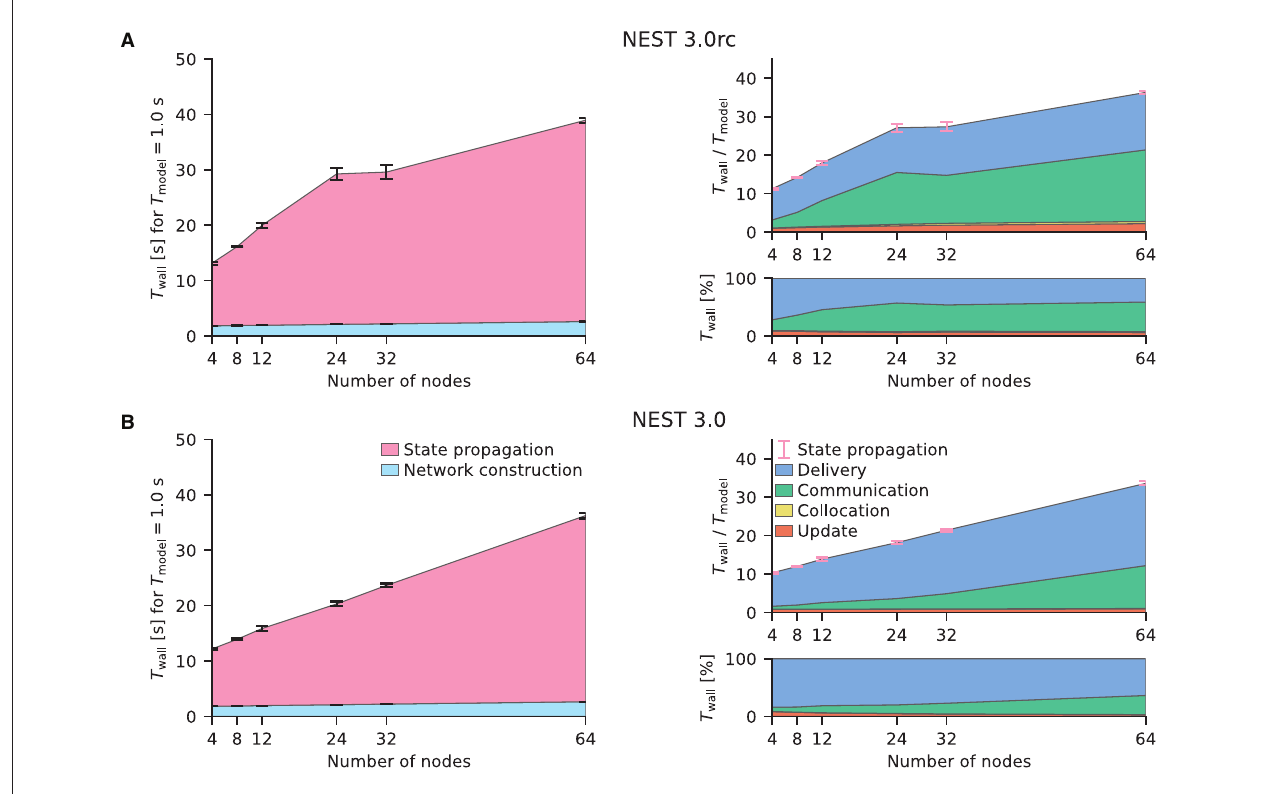
FIGURE 4 | Weak-scaling performance of the HPC-benchmark model on JURECA-DC. (A) NEST 3.0rc . The left graph shows the absolute wall-clock time T wall measured with Python-level timers for both network construction and state propagation [legend in (B) ]; the model time is T model = 1s. Error bars indicate variability across three simulation repeats with different random seeds. The top right graph displays the real-time factor defined as wall-clock time normalized by the model time. Built-in timers resolve four different phases of the state propagation [legend in (B) ]: update, collocation, communication, and delivery. Pink error bars show the same variability of state propagation as the left graph. The lower right graph shows the relative contribution of these phases to the state-propagation time. Same colors used for phases as in Figure 3 . (B) NEST 3.0 . Same display as (A)